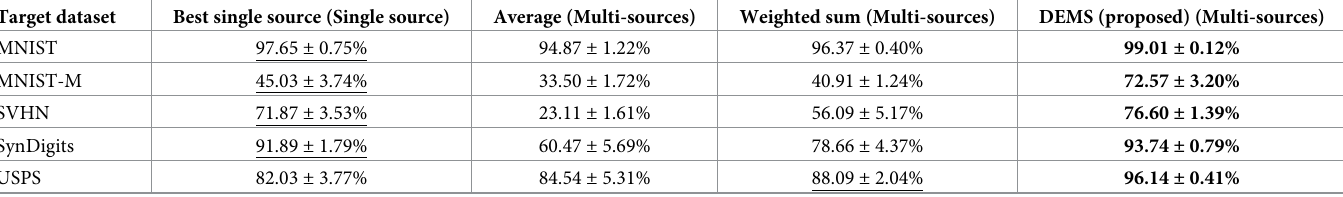
Table 5. Classification accuracy of DEMS and baselines.